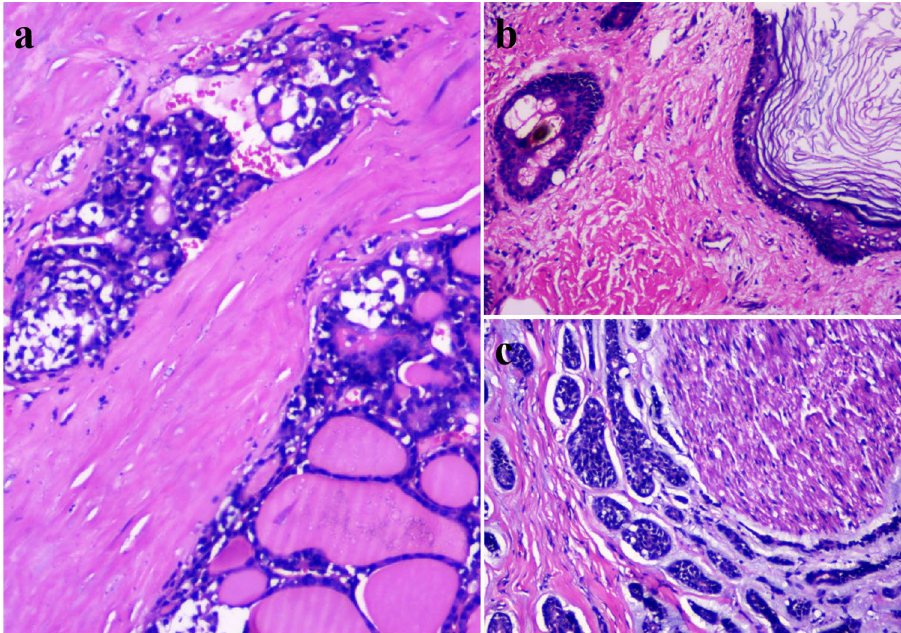
Figure 3. Pathological examination of the tumor dignity (H & E staining, × 100). Thyroid follicular carcinoma of Case 1 ( a ). Mature cystic teratoma of Case 2 ( b ). Adenoid cystic carcinoma of Case 3 ( c